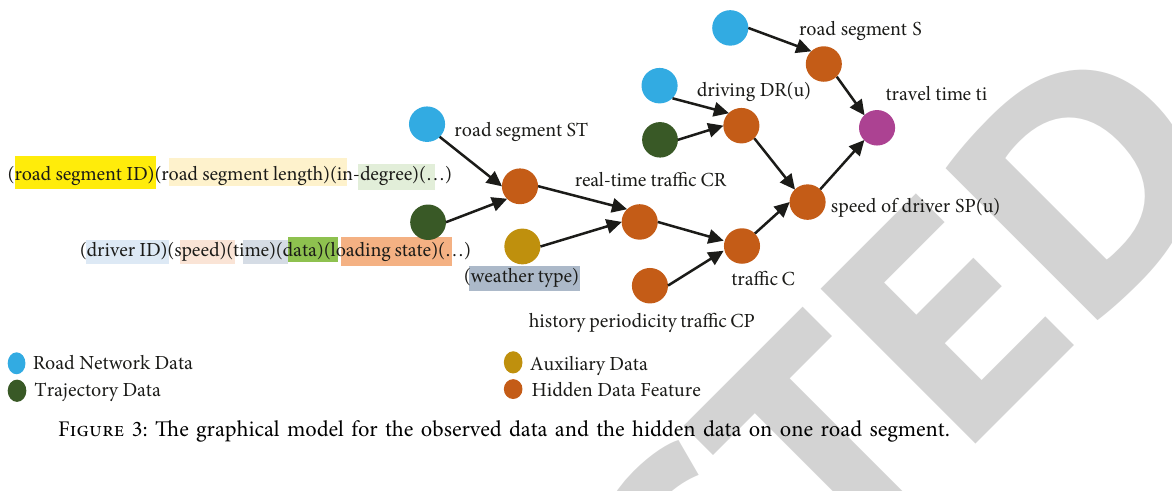
Figure 3: The graphical model for the observed data and the hidden data on one road segment. Table 1: Notations and